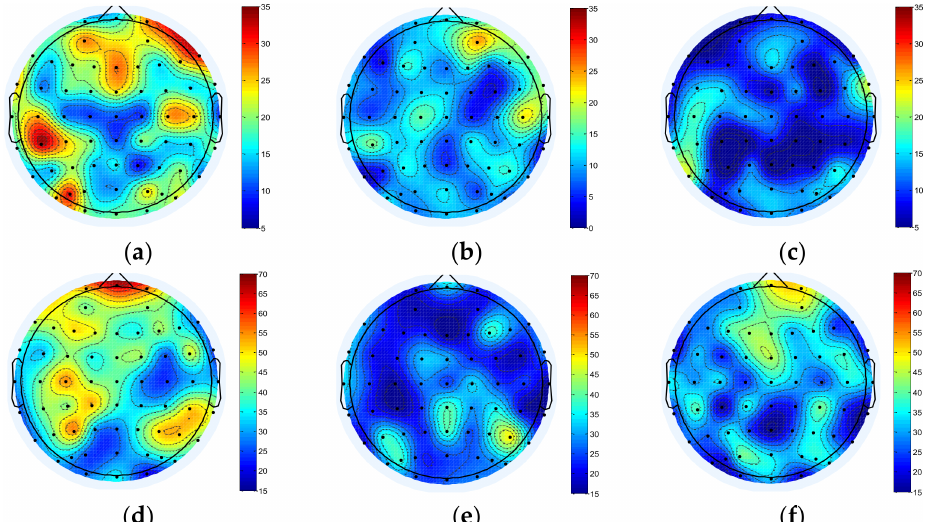
Figure 6. BIM of mu/beta in three different states of motor imagery. ( a ) BIM before motor imagery task in the mu rhythm. ( b ) BIM during motor imagery task in the mu rhythm. ( c ) BIM after motor imagery task in the mu rhythm. ( d ) BIM before motor imagery task in the beta rhythm. ( e ) BIM during motor imagery task in the beta rhythm. ( f ) BIM after motor imagery task in the beta rhythm. The color scale in the figure is generated based on the value of characteristic parameters of two different frequency bands.